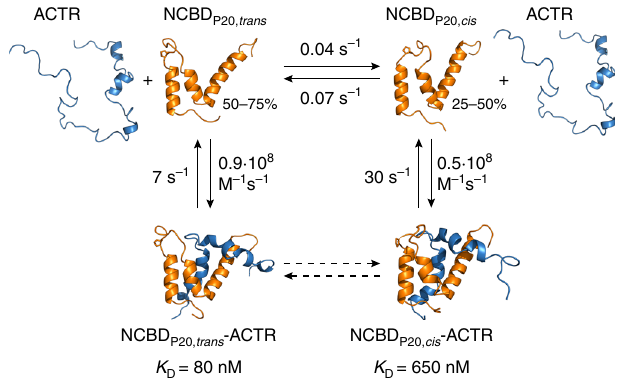
Fig. 5 Kinetic model of the NCBD-ACTR interaction. The two subpopulations of NCBD differ by the cis / trans isomers of the peptide bond involving Pro20, which are interconverting slowly; both bind ACTR, but with different association rate coef fi cients. The two complexes can be distinguished experimentally by their dissociation rate coef fi cient, which is greater for the NCBD P20, cis -ACTR complex. The difference in association and dissociation rates translates into an eightfold higher af fi nity of the NCBD P20, trans -ACTR four states: NCBD with Pro20 in trans , which binds ACTR with higher af fi nity, and NBCD with Pro20 in cis , which binds ACTR with lower af fi nity. This difference in af fi nity is largely caused by a change in dissociation rate coef fi cient; the association rate